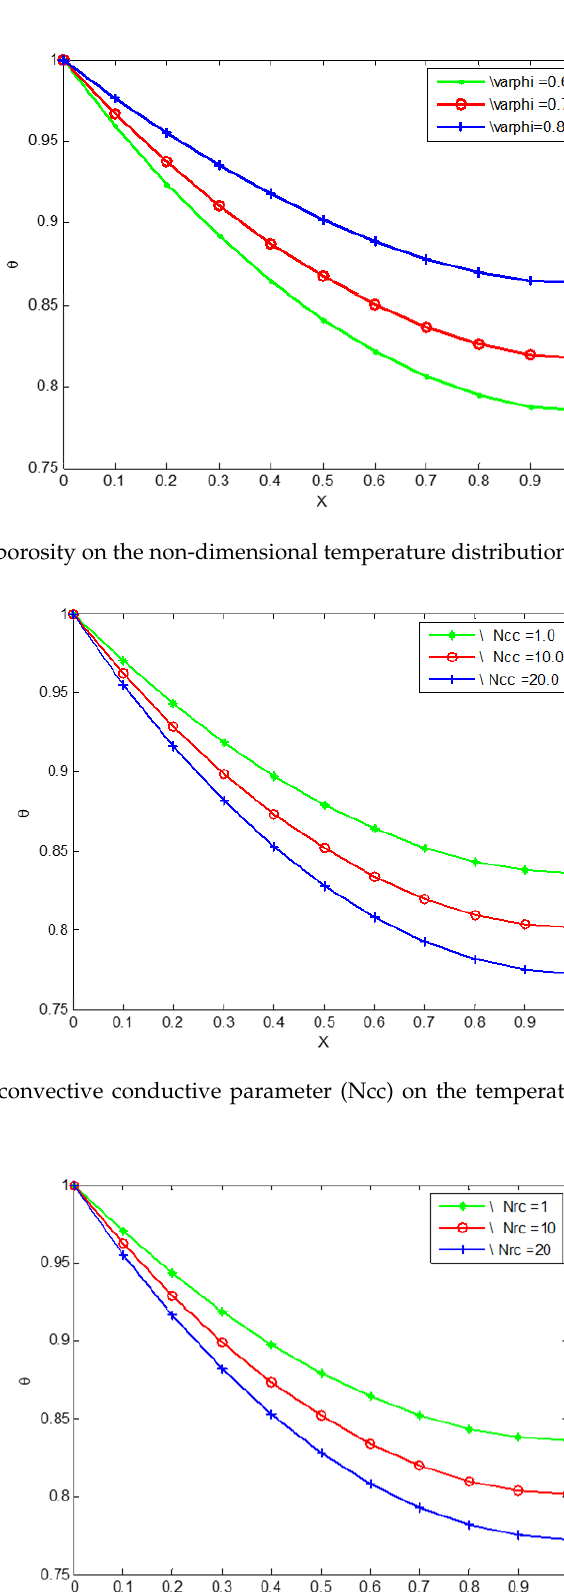
and in Figure 15, radiative conductive parameter Nrc is examined. Convective conductive parameter (Ncc) connotes ratio of convective heat dissipation to that of conductive heat transfer. As convective